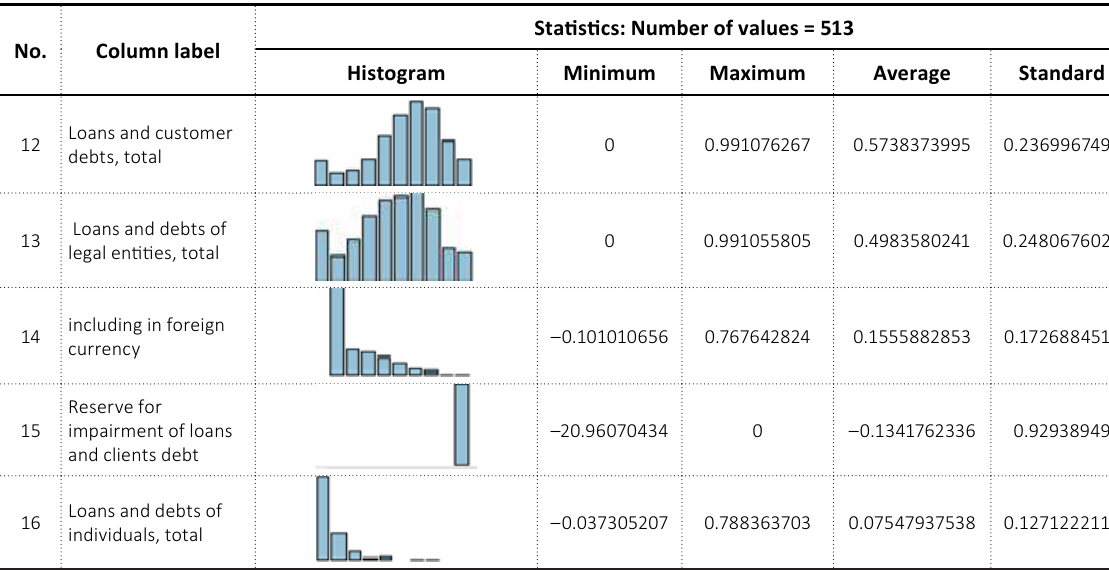
Table 1. Statistical analysis of input data